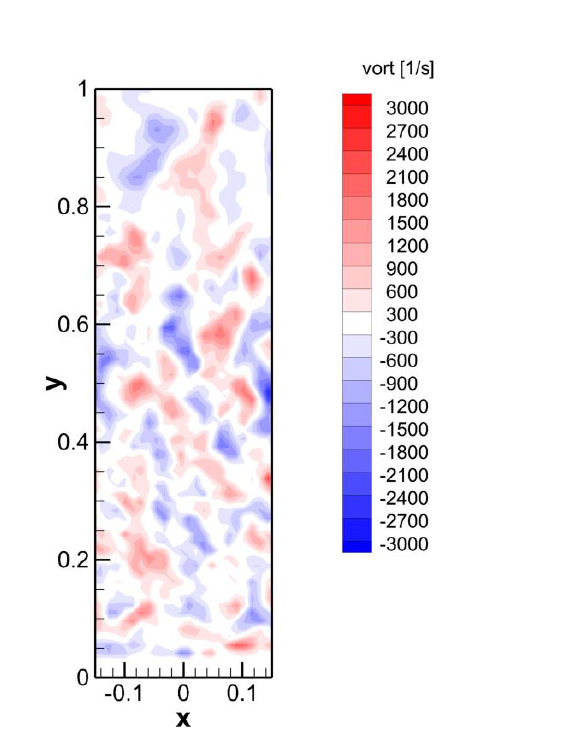
Fig. 6. Instantaneous vorticity